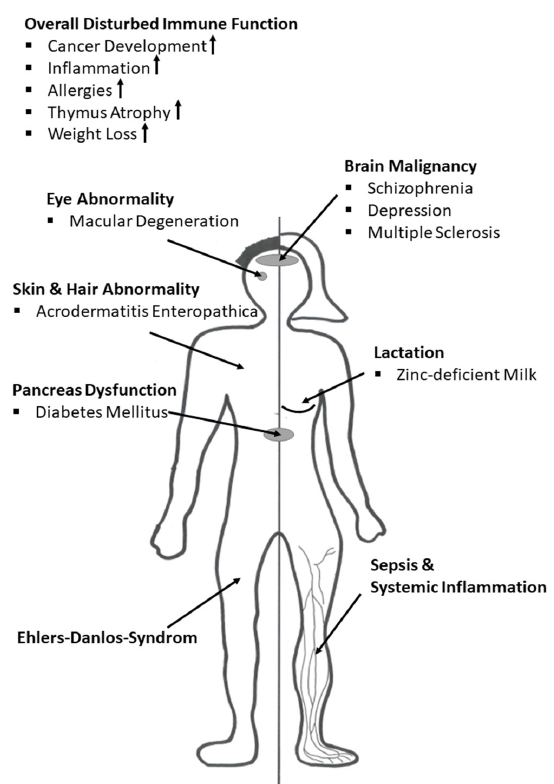
Figure 4. Influence of zinc and zinc deficiency on various organ systems as well as on the immune system. Zinc deficiency is causally associated with multiple immunological dysfunctions that lead to the manifestation of various diseases indicated in this figure. For a detailed explanation see the text. Modified after [5]. ↑ = upregulted/enhanced.